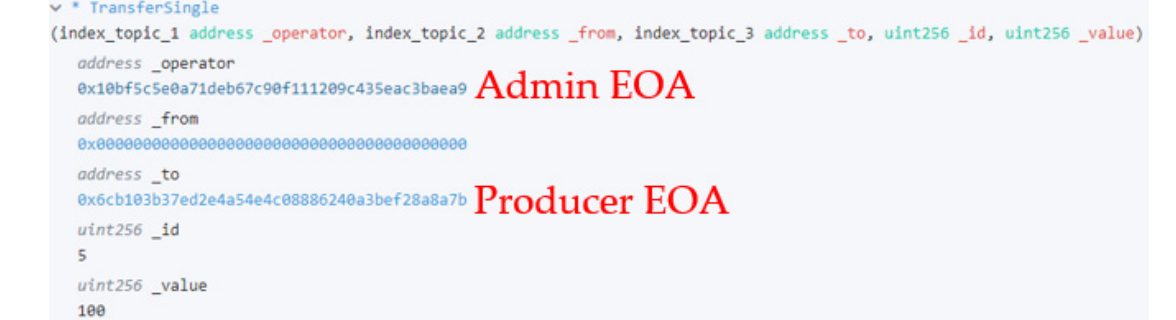
Figure 15. Blockchain token transfer log.